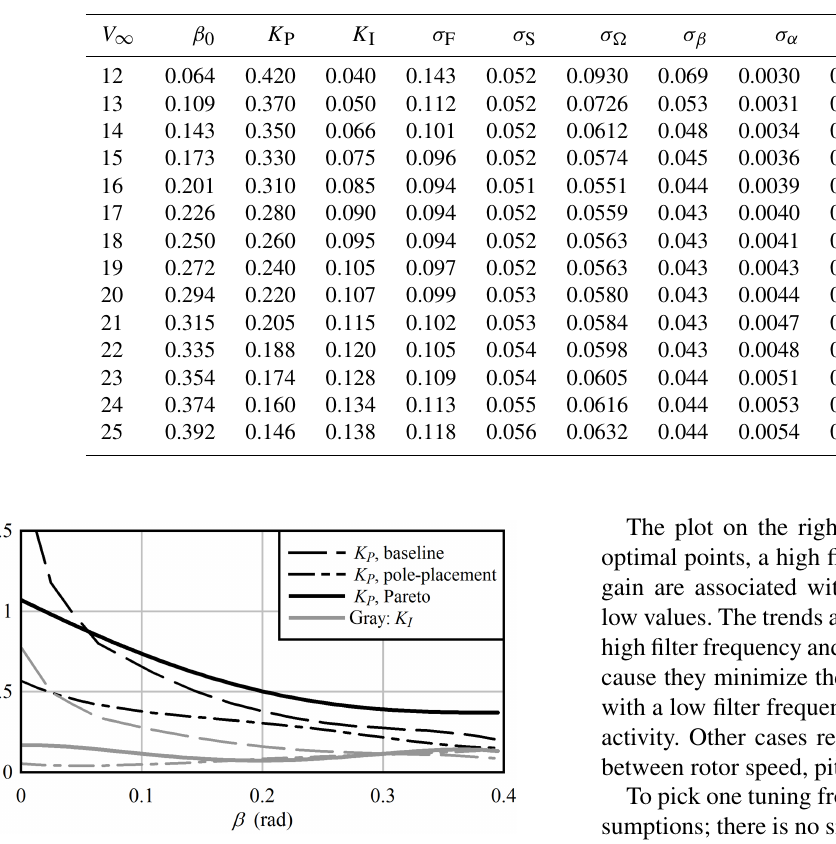
Figure 18. A comparison of the gains, scheduled as a function of the pitch